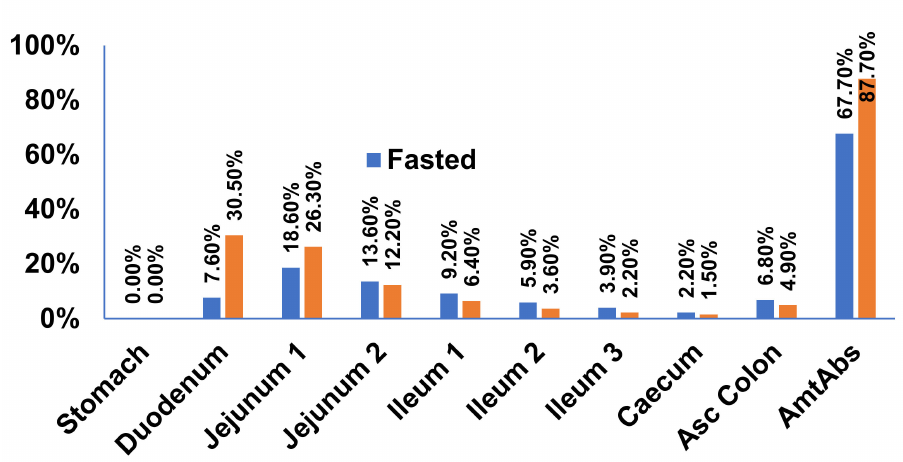
Figure 6. Regional amount absorbed from Xarelto in fasted and fed states in the gastrointestinal